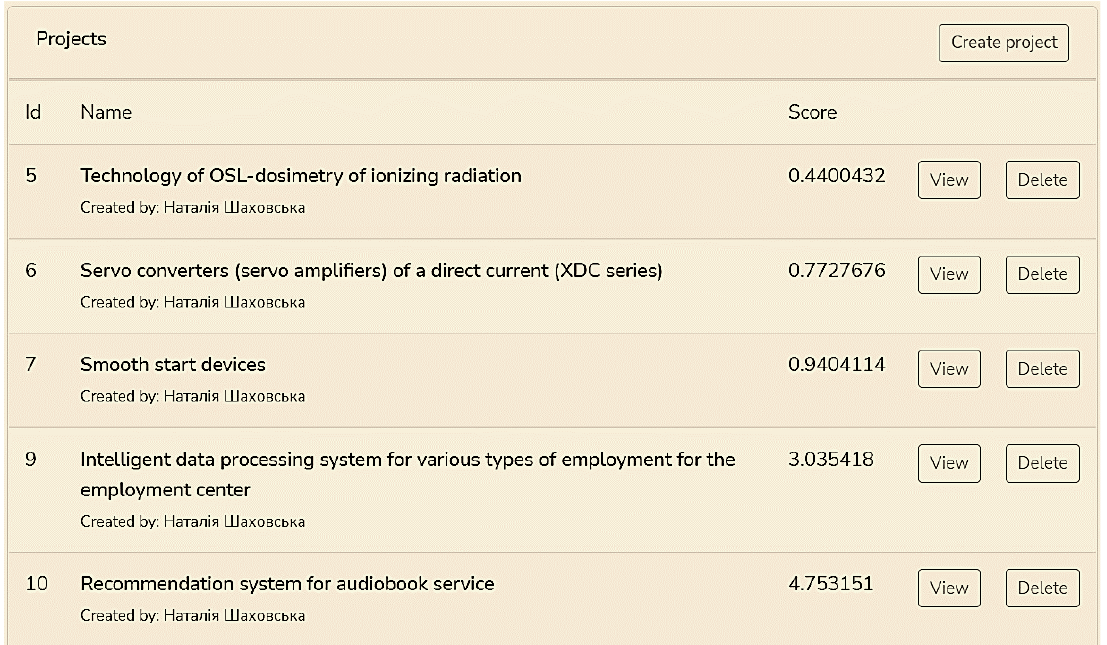
Figure 8. The main page of the information technology.